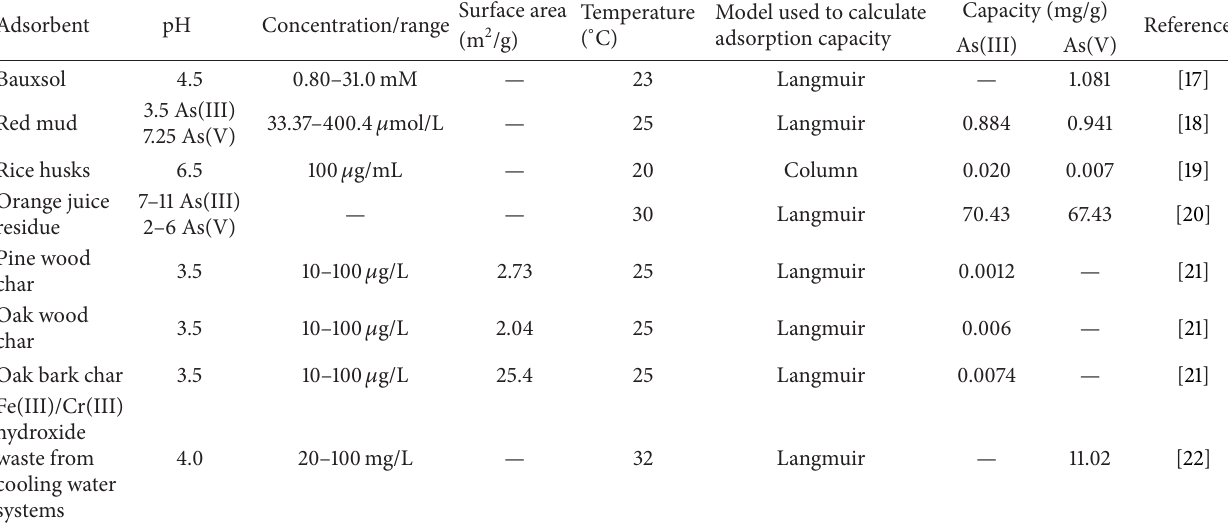
Table 4: Comparative evaluation of various industrial by-products as adsorbents for arsenic removal.